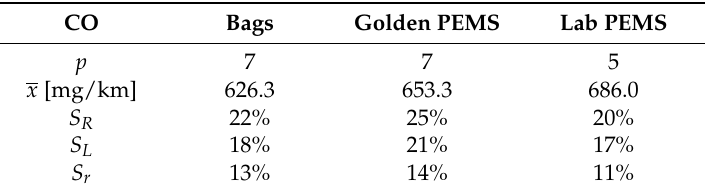
Table A2. Statistical analysis results for CO.